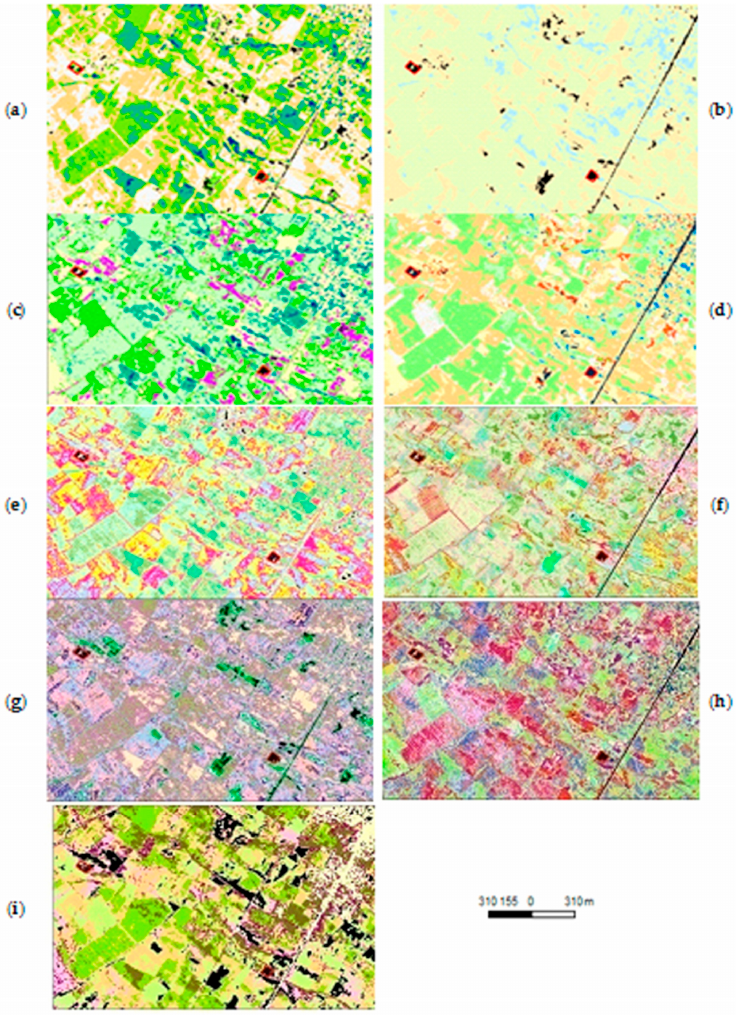
Figure 8. ISODATA classification for Tunisian study areas; ( a ): unsupervised classification using Sentinel-2 RGB image in February, ( b ): unsupervised classification using Sentinel-2 RGB image in August, ( c ): unsupervised classification using Sentinel-2 Composite 3 in February, ( d ): unsupervised classification using Sentinel-2 Composite 3 in August, ( e ): unsupervised classification using Plan- etScope RGB image in February, ( f ): unsupervised classification using PlanetScope RGB image in August, ( g ): unsupervised classification using PlanetScope Composite 3 in February, ( h ): unsuper- vised classification using PlanetScope Composite 3 in August, ( i ): unsupervised classification using Sentinel-2 Composite 1 image in February; OMW disposal areas are indicated inside the red frame.